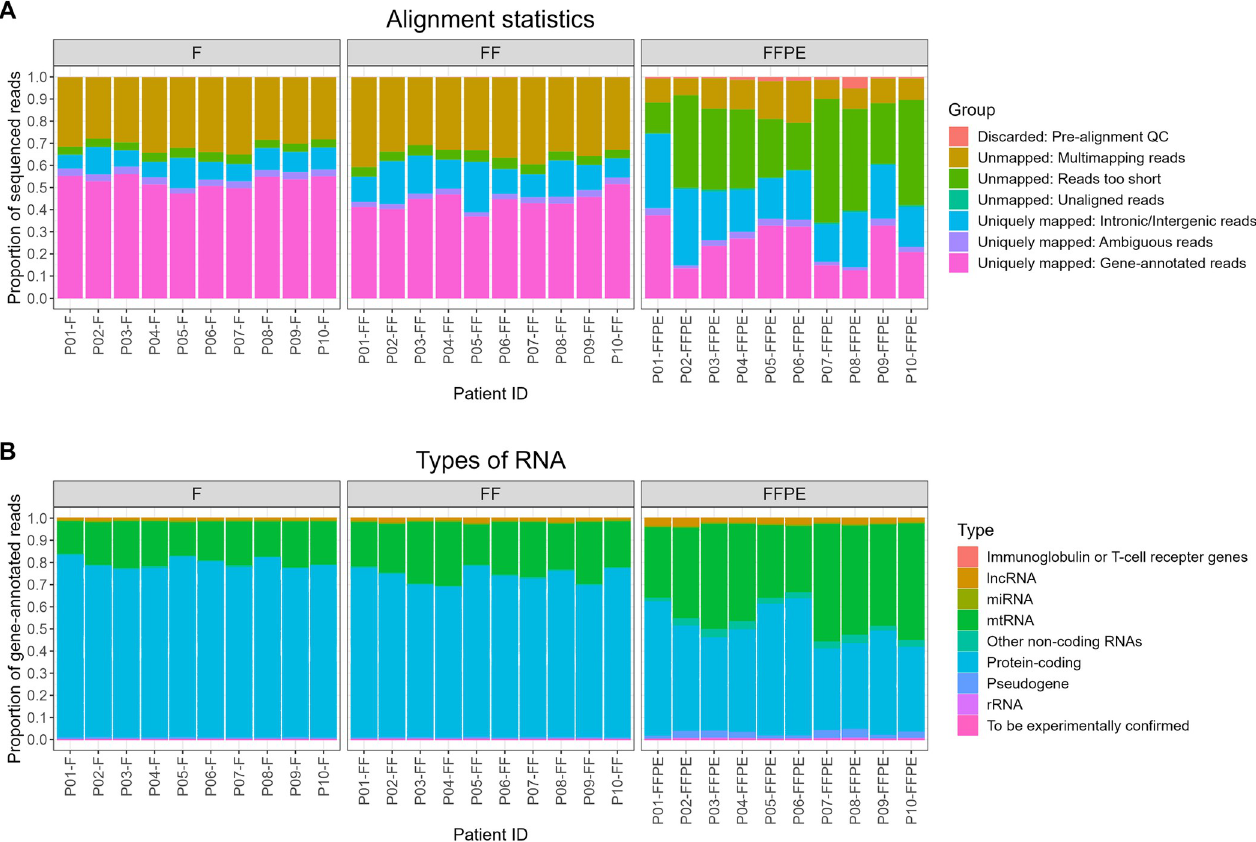
Fig 2. Alignment statistics and RNA subtypes from fresh, frozen, and formalin-fixed, paraffin-embedded (FFPE) cardiac tissue. (A) Stacked bar plots of the proportions of unmapped and uniquely mapped reads per patient. (B) Stacked bar plots of the proportions of RNA subtypes. Abbreviations: F = Fresh tissue, FF = Frozen tissue, lncRNA = Long non-coding RNA, miRNA = MicroRNA, mtRNA = Mitochondrial RNA, rRNA = Ribosomal RNA, QC = Quality control.